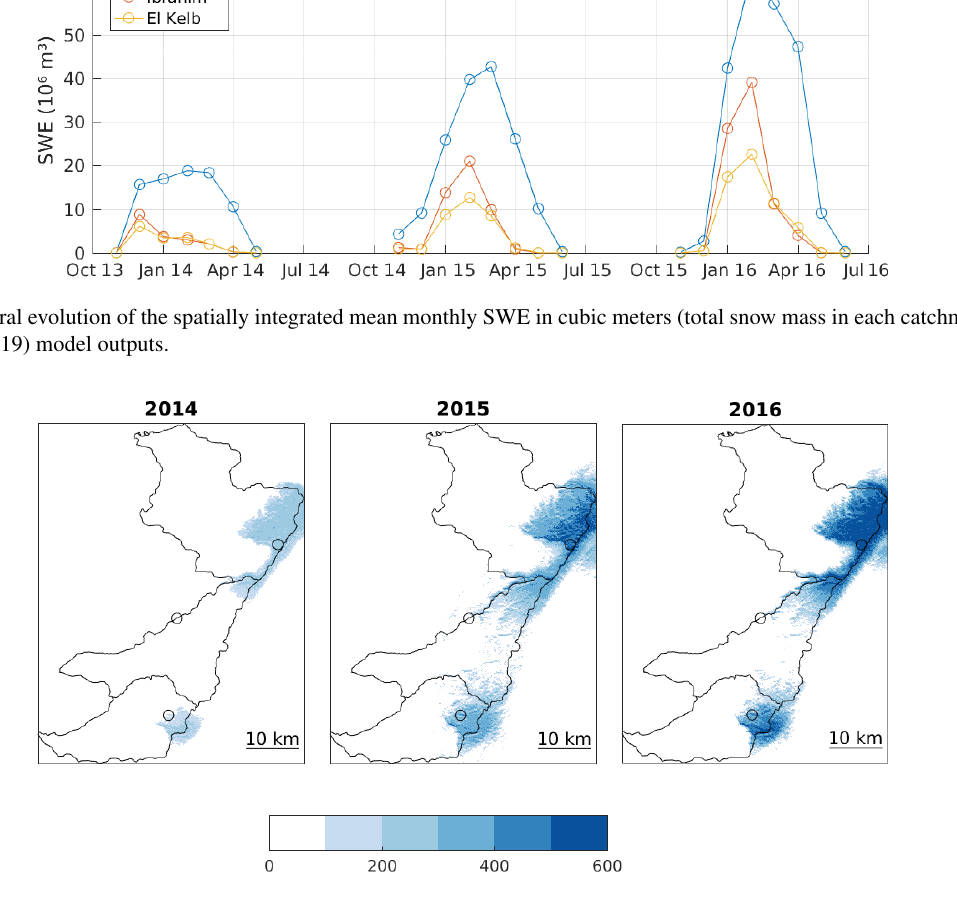
Figure 11. Spatial distribution of the simulated SWE (in mm) on 1 March. Here the Pflug et al. (2019) model outputs are